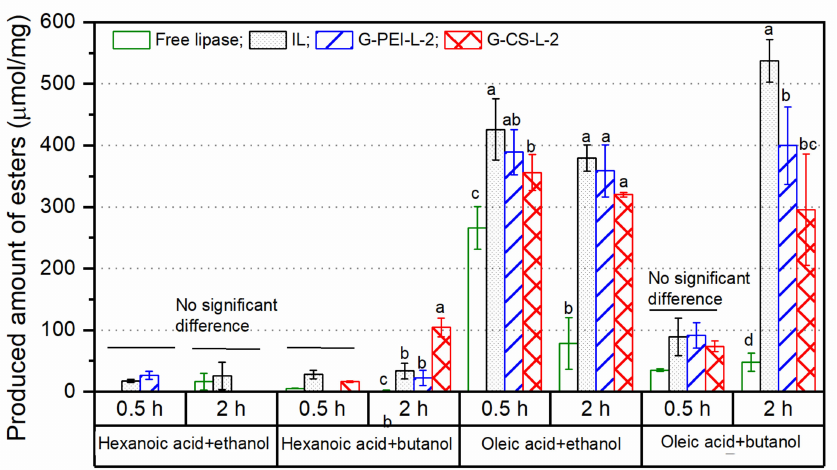
Figure 8. Esterification capacity toward different pairs of fatty acid and alcohol. The esterification capacity was described by the amount of ester produced by per milligram of dried immobilized lipase preparations or dried lipase powder (free form). Different lowercase letters indicate significant differences among the applied biocatalysts for each reaction at 0.5 or 2 h ( p <